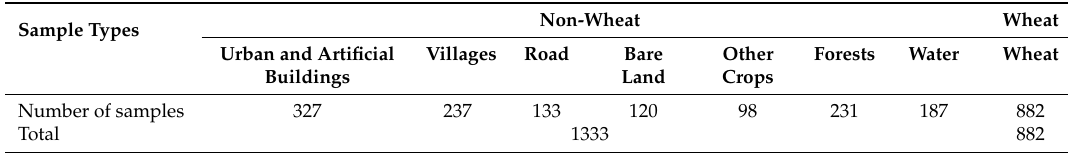
Table 2. Samples of the di ff erent land covers.